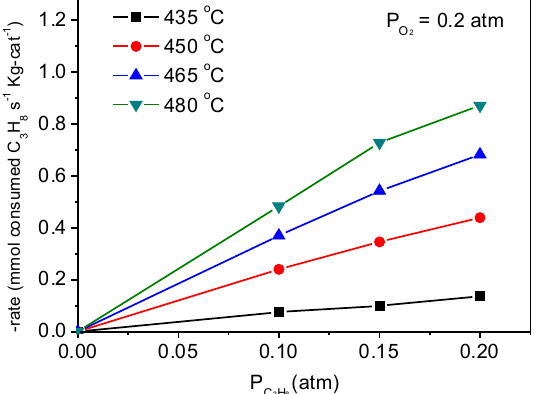
Figure 3. Rates of propane consumption as a function of P C 3 H 8 (P O 2 constant at 0.2 atm) with linear fitting. Reaction conditions: N 2 balance, mass space velocity 4000 mL · (h · g-cat) − 1 , 0.3 g L-coal, 20–40 mesh.